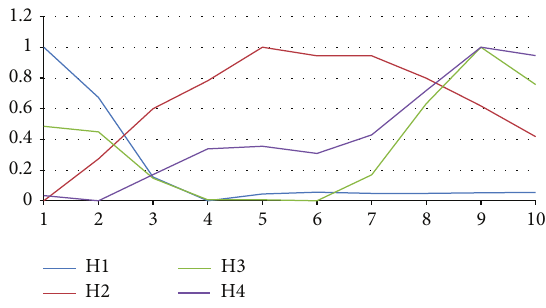
Figure 6: Patterns representing healthy persons.